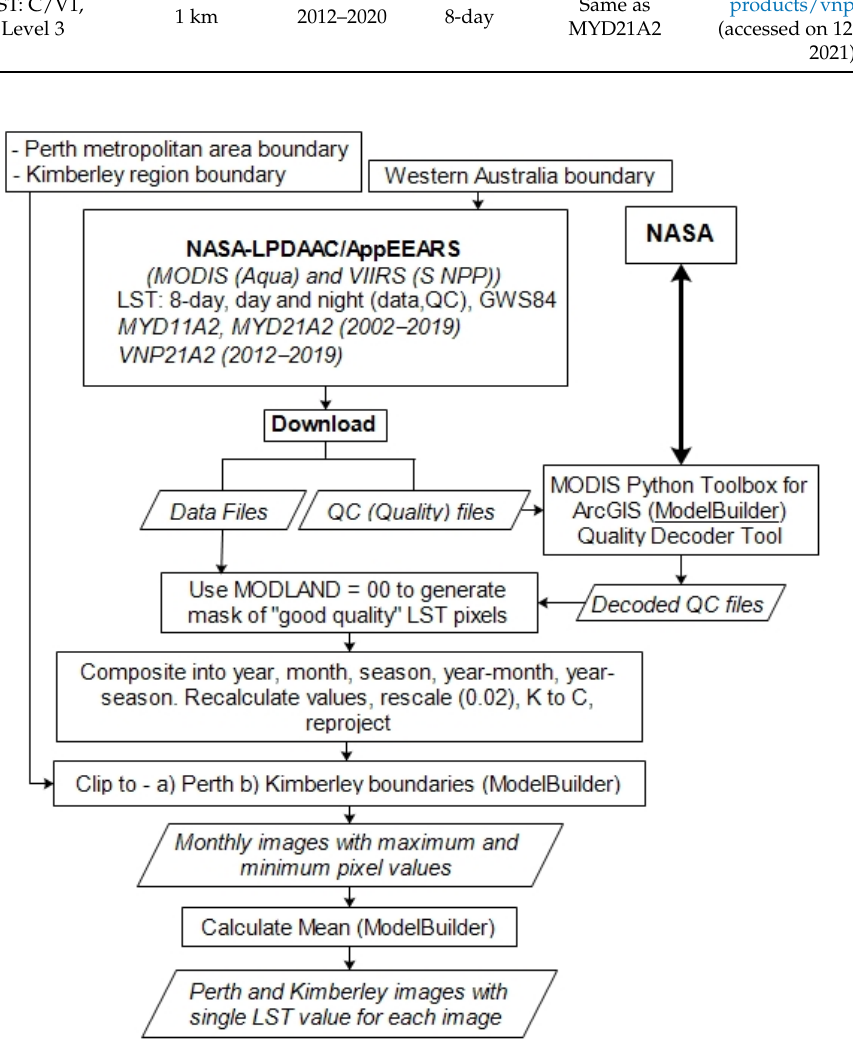
Figure 2. Flowchart of the LST processing.